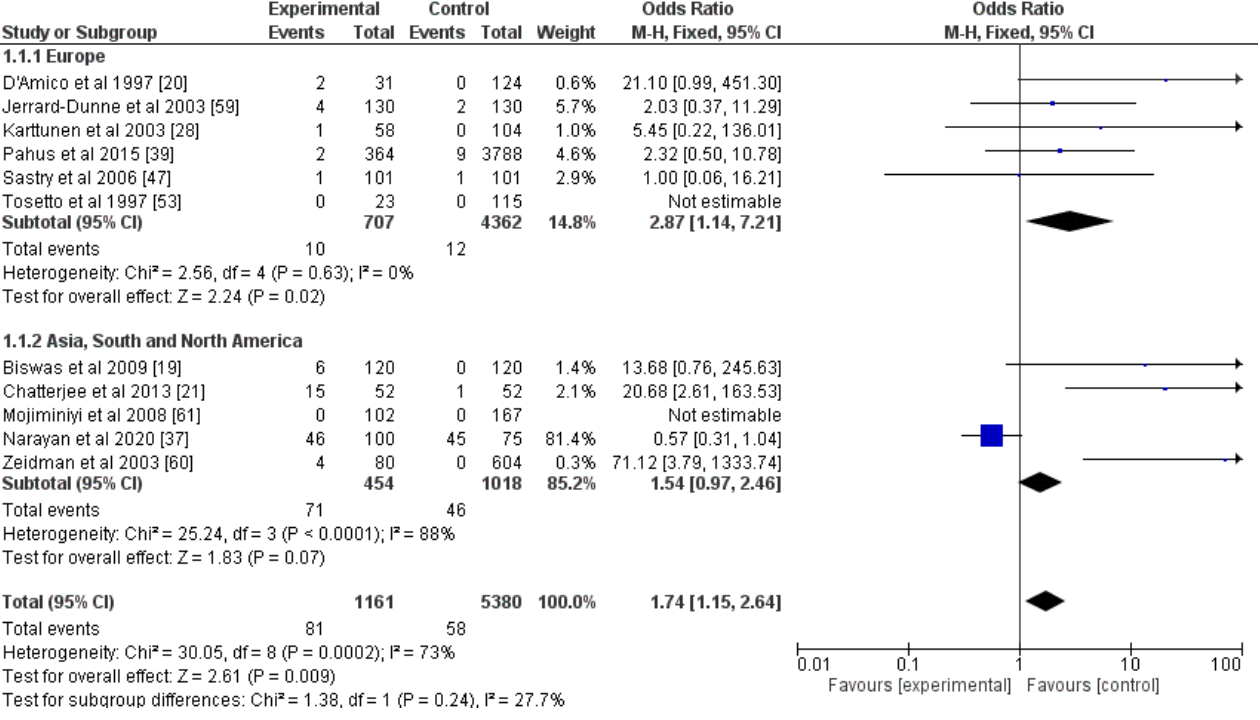
Figure 5. Forest plot for protein S and subgroup analysis based on geographic location of the study. Blue squares indicate odds ratios. Black rhombi indicate overall effect. Vertical line indicates null effect, and horizontal lines indicate values of odds ratios.